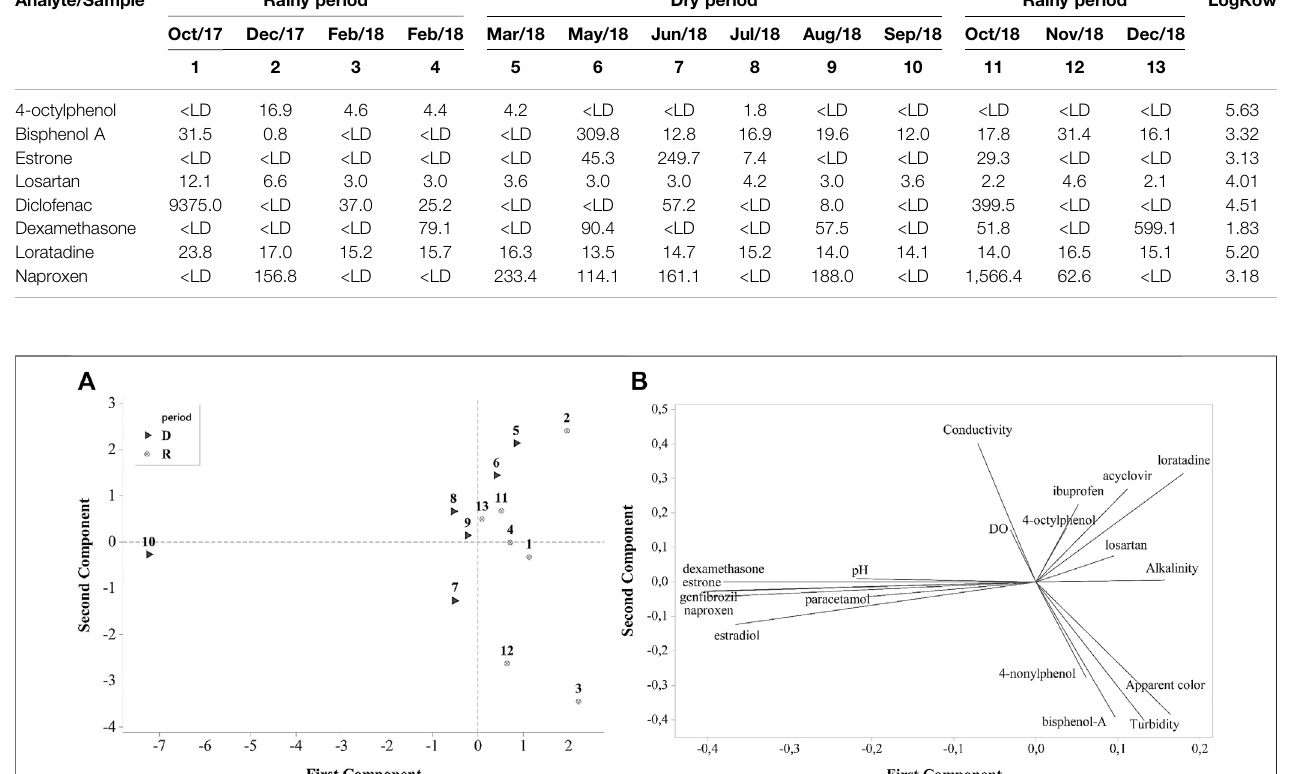
FIGURE 2 | Analysis of principal components (PCA) of the contaminants present in the WTP-Jataizinho: (A) scores plot, (B) loading plot.